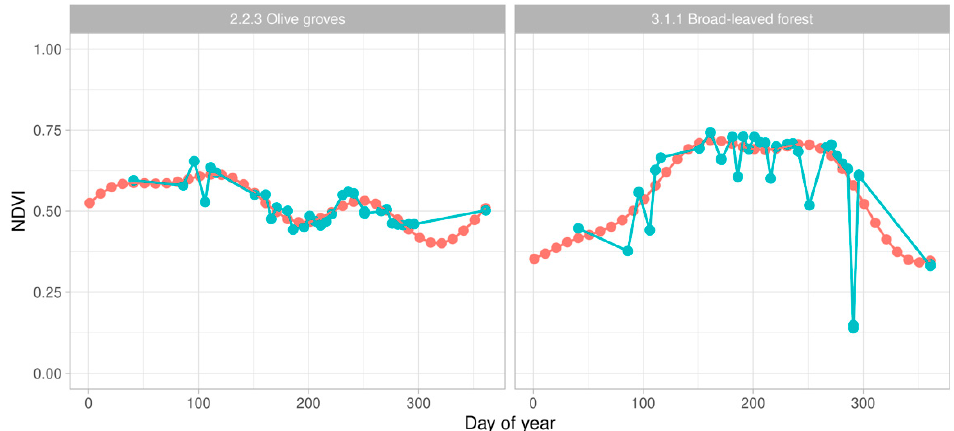
Figure 4. A sample of NDVI 2018 profiles for two highly widespread Corine Land Cover classes in the study area (olive grove and broad-leaved forest). Cyan values are NDVI 2018 original trajectories, interpolated harmonic trajectories are in red.